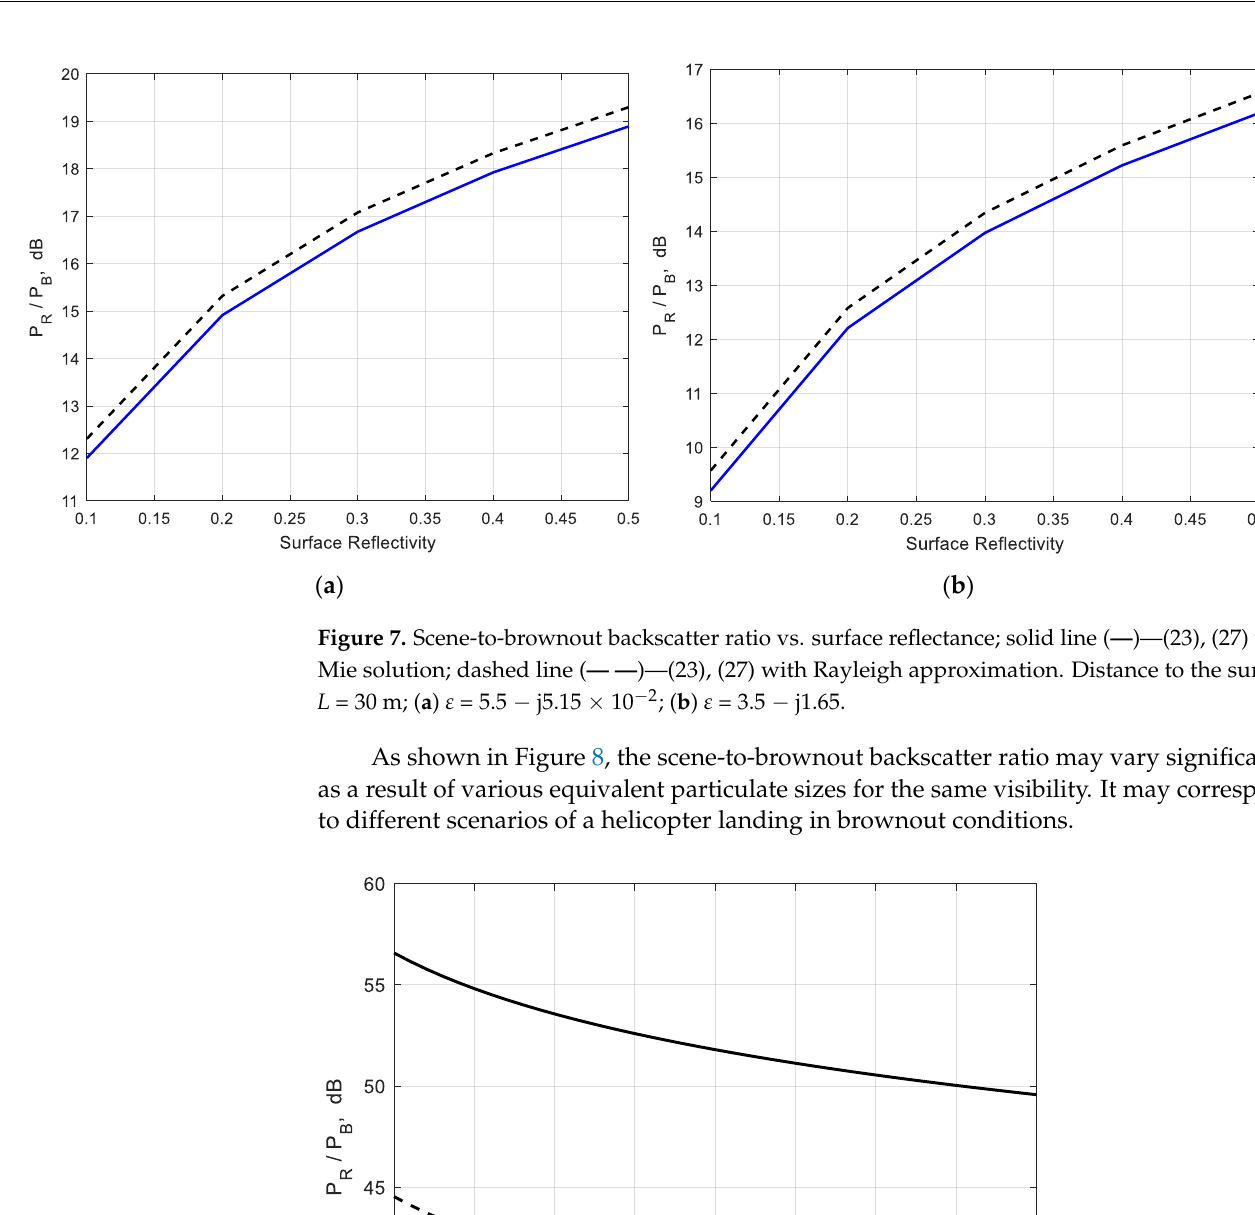
Figure 6. Scene-to-brownout backscatter ratio vs. distance to surface; solid line ( ― ) — (23), (27) with Mie solution; dashed line ( ‒ ‒ ) — (23), (27) with Rayleigh approximation. Surface reflectance: ρ = 0.15;